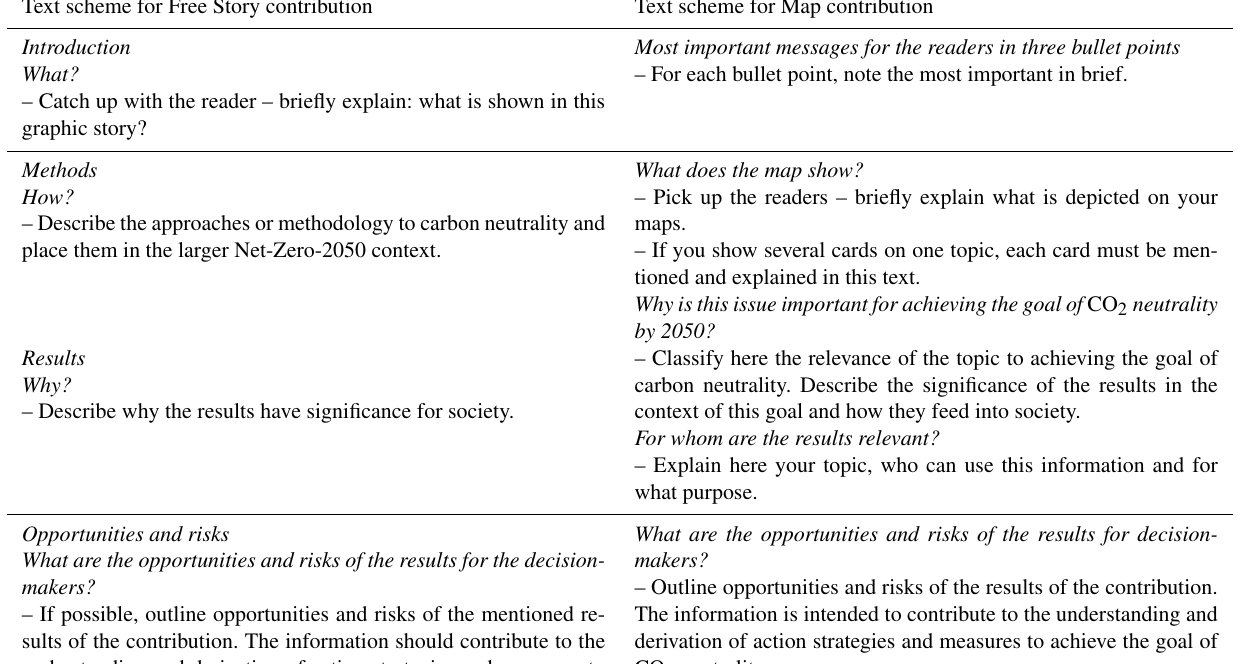
Table 1. Guiding Structures Free Story and Map contribution, given to the project partners for preparing the atlas contents. Text scheme for Free Story contribution